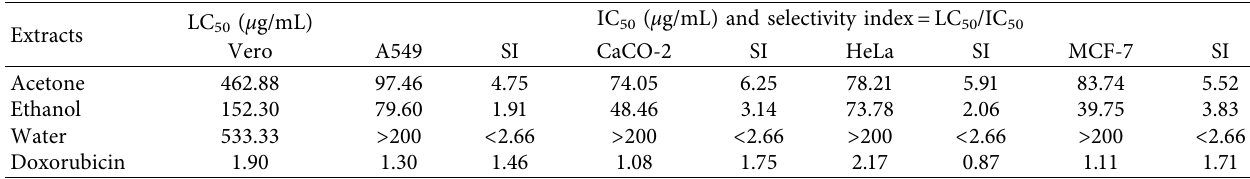
Table 6: Activities of various leaf extracts of Croton gratissimus and standard (doxorubicin hydrochloride) on noncancerous and cancerous cell lines